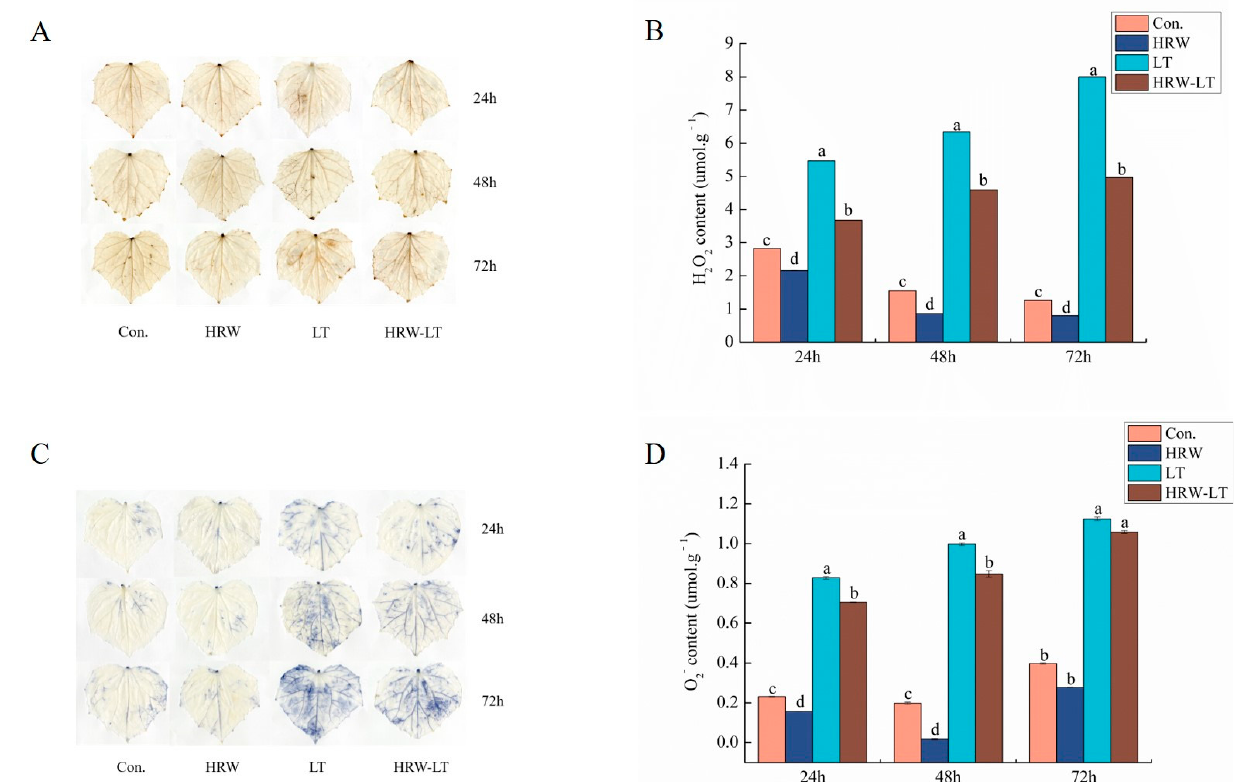
Figure 9. Effect of HRW on the accumulation of H 2 O 2 and O 2 − of cucumber seedlings under chilling stress. ( A ) DAB staining; ( B ) H 2 O 2 content; ( C ) NBT staining; ( D ) O 2 − content. Data are the mean ± standard deviation of three biological replicates. The different letters indicate a significant difference ( p < 0.05).